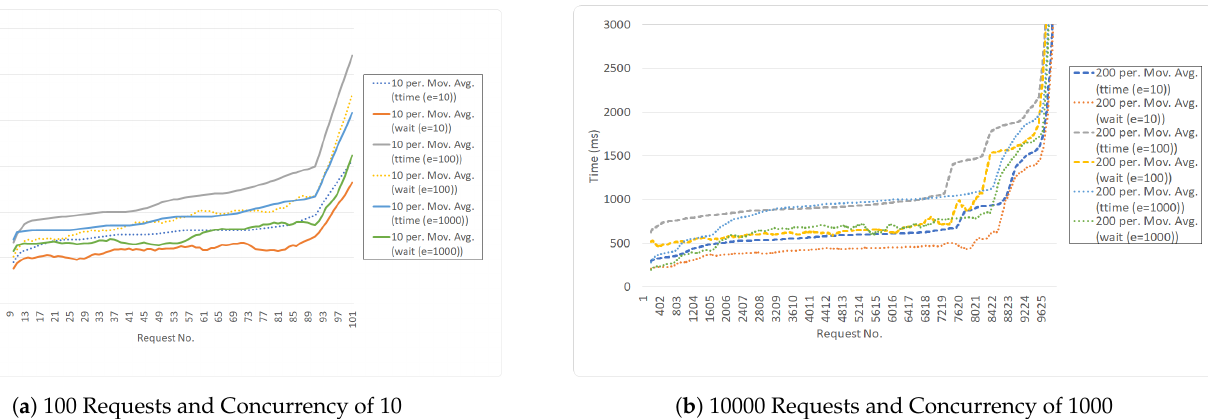
Figure 11. Indexing response